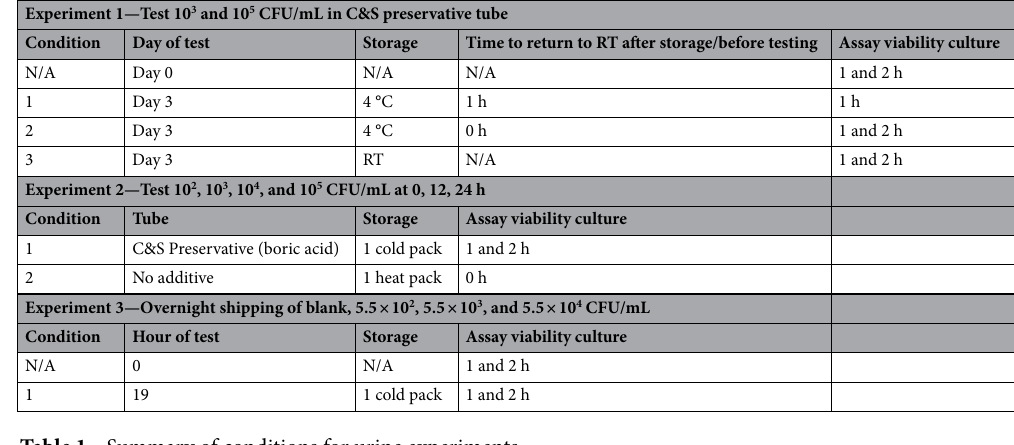
Table 1. Summary of conditions for urine